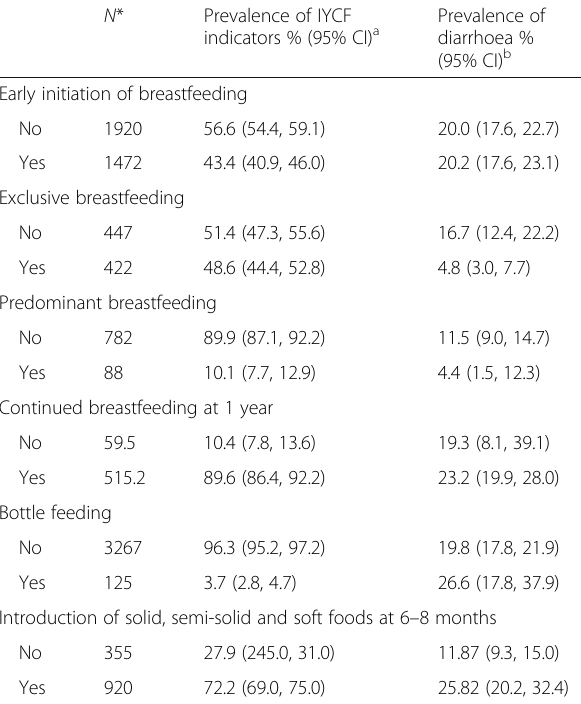
Table 2 Prevalence of IYCF indicators and diarrhoea among children 0 – 23 months in Tanzania, TDHS